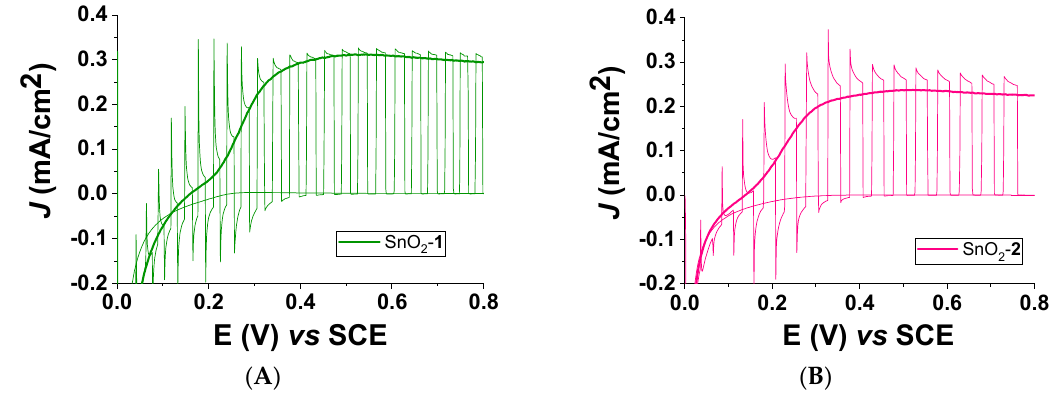
Figure 8. J/E curves of SnO 2 - 1 ( A ) and SnO 2 - 2 ( B ) photoanodes recorded in 0.1 M HBr (pH 1) under AM 1.5 G (0.1 W/cm 2 ) illumination through the FTO side.